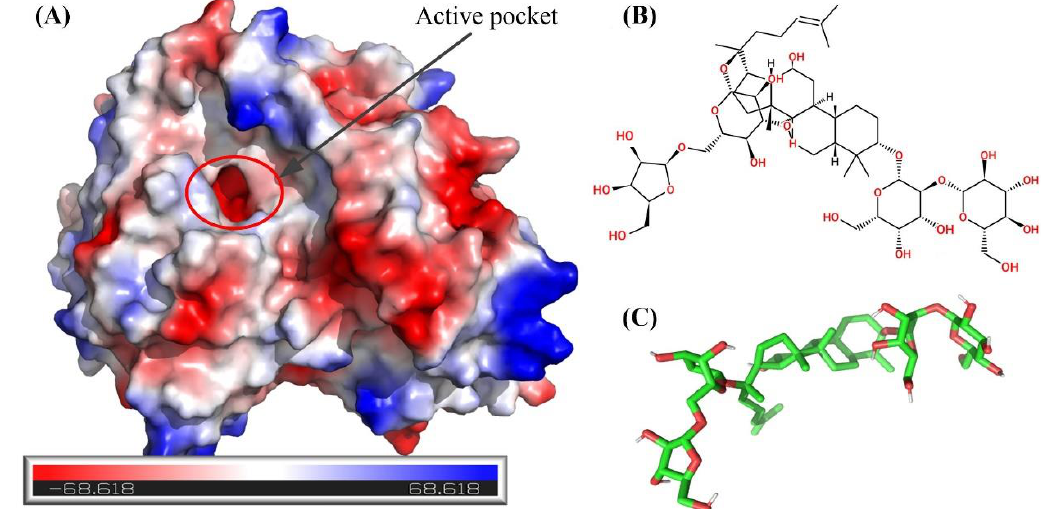
Figure 8. ( A ) Surface electro-static potential plot at the active site of BsAbfA receptor, ( B ) structure of ginsenoside Rc, and ( C ) geometry of ginsenoside Rc (non-polar hydrogens are implicit). Coloring represents the electrostatic surface potential (KbT/ec) with a spectrum of red (electronegative) to blue (electropositive). The red circles show the active pocket. Table 5. Cluster analysis of the docking position (kcal/mol).